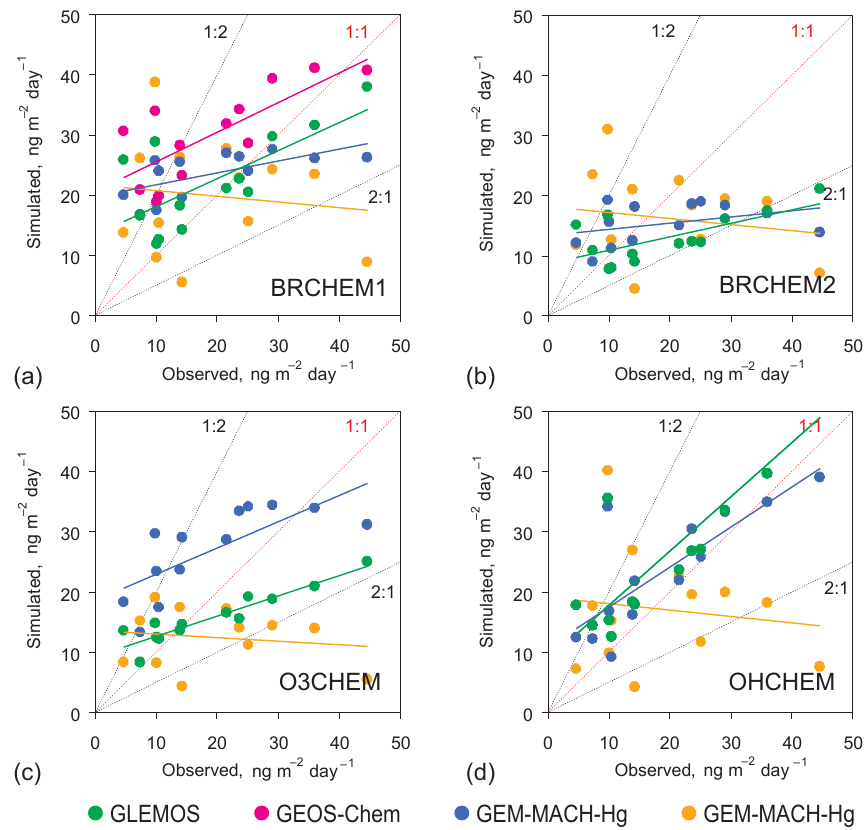
Figure 11. Scatter plots of simulated vs. observed annual mean wet deposition flux in 2013 averaged over different territorial groups of sites (see Table S3 in the Supplement) for different model experiments: (a) BrCHEM1, (b) BrCHEM2, (c) O3CHEM, and (d) OHCHEM. Solid lines depict linear approximation. Dotted red line depicts the 1 : 1 ratio; dotted black lines show deviation by a factor of